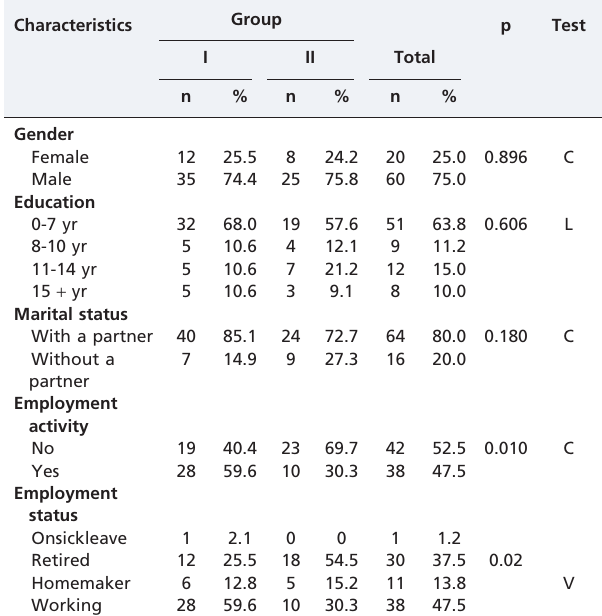
Table 1 - Socio-demographic characteristics of the study